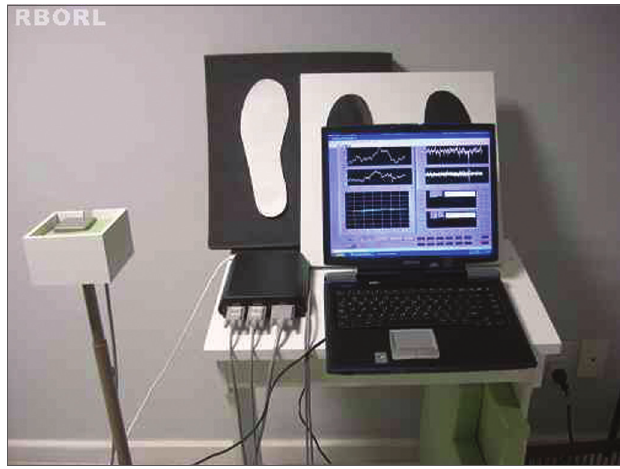
Figura 1. Equipamento utilizado no estudo: Polhemus, notebook e plataformas de exames.